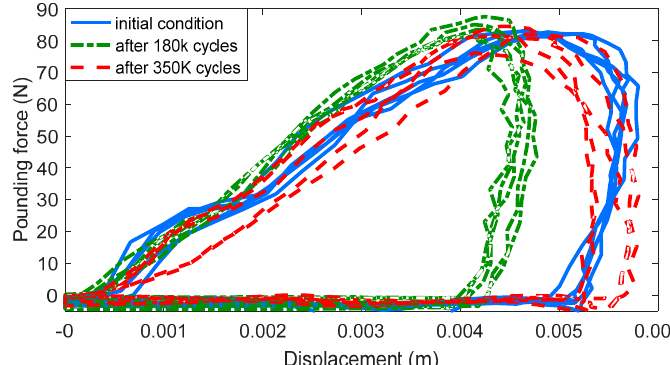
Figure 6. Typical hysteresis loops of the viscoelastic material after cyclic impacts.